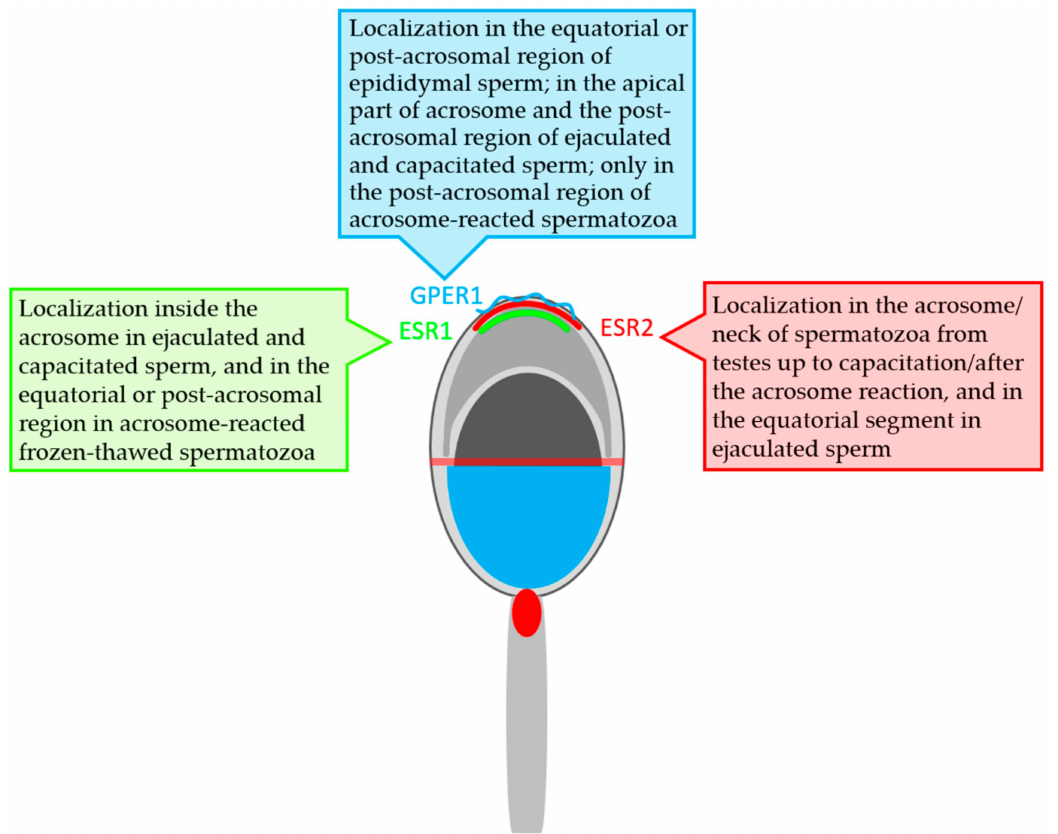
Figure 8. Graphical scheme of localization of the estrogen receptors in bull